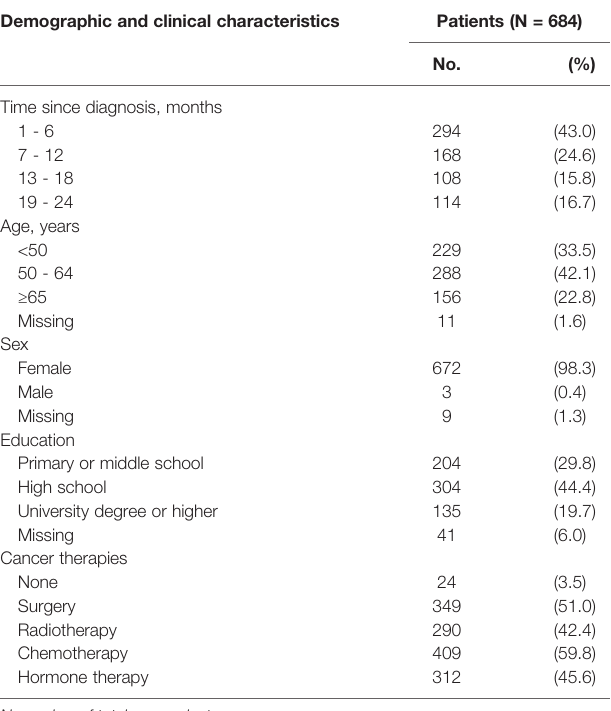
TABLE 1 | Demographic and clinical characteristics of overall patient sample (N = 684).